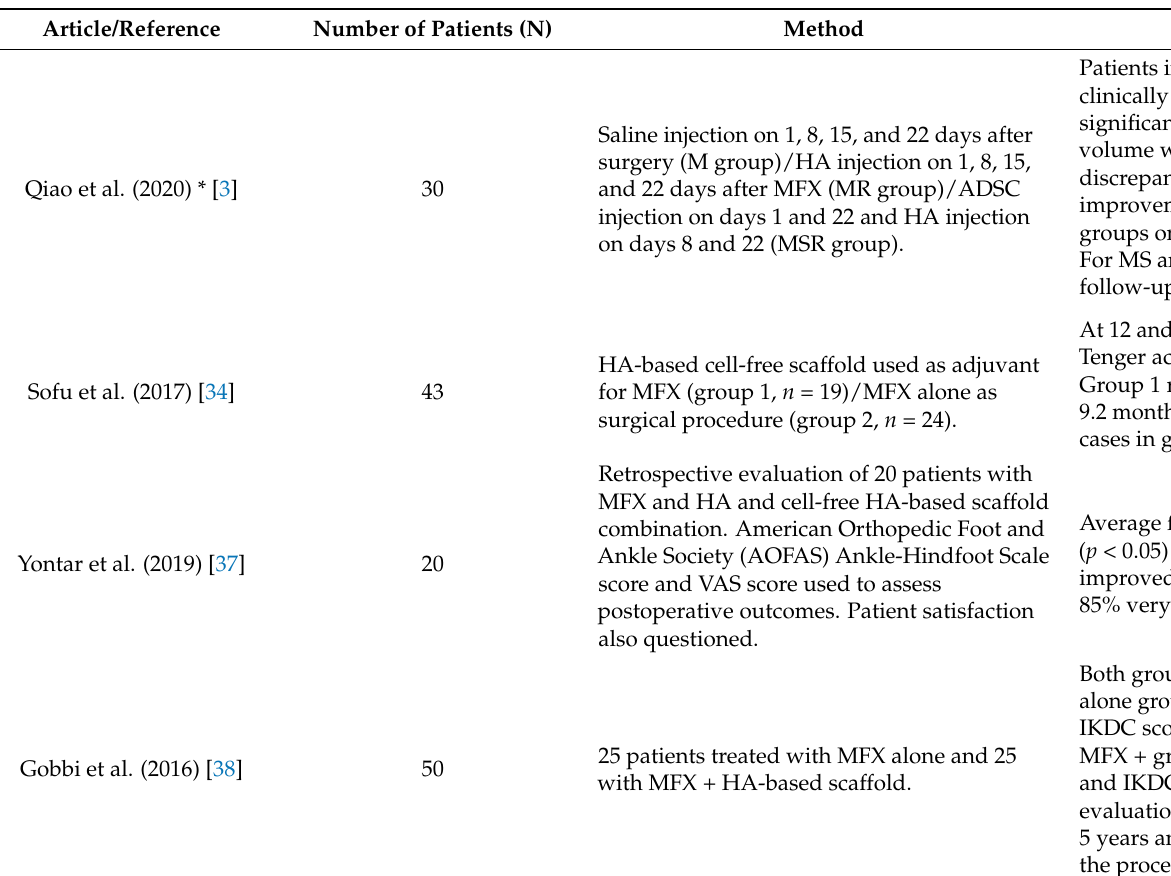
Table 2. HA as an adjuvant therapy for